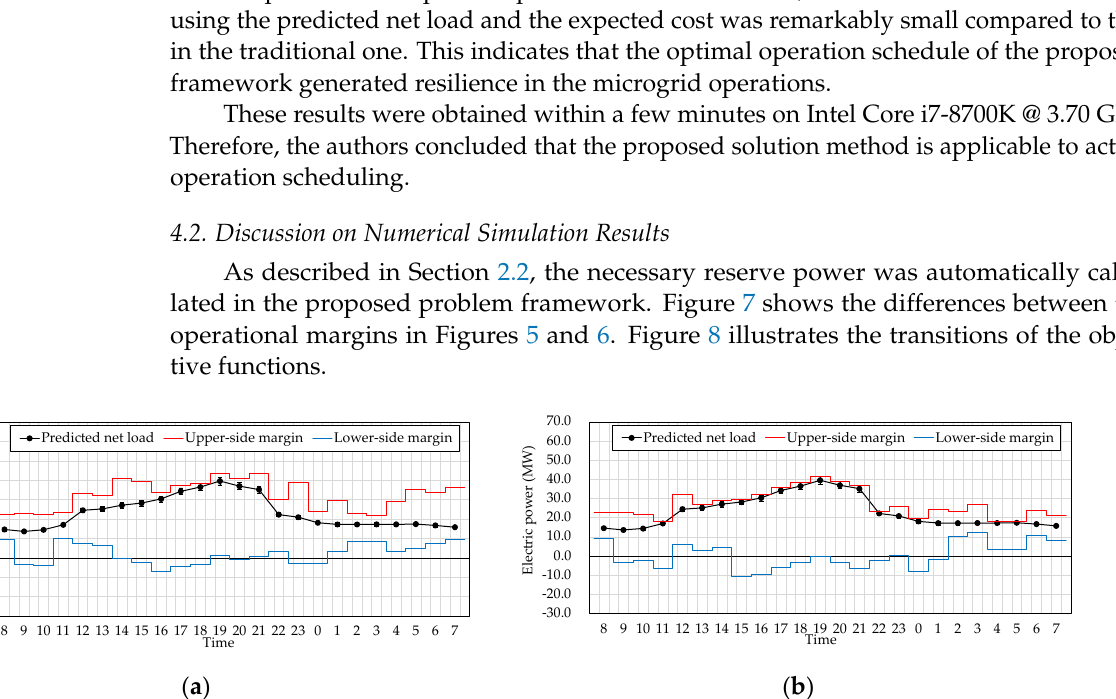
Traditional framework